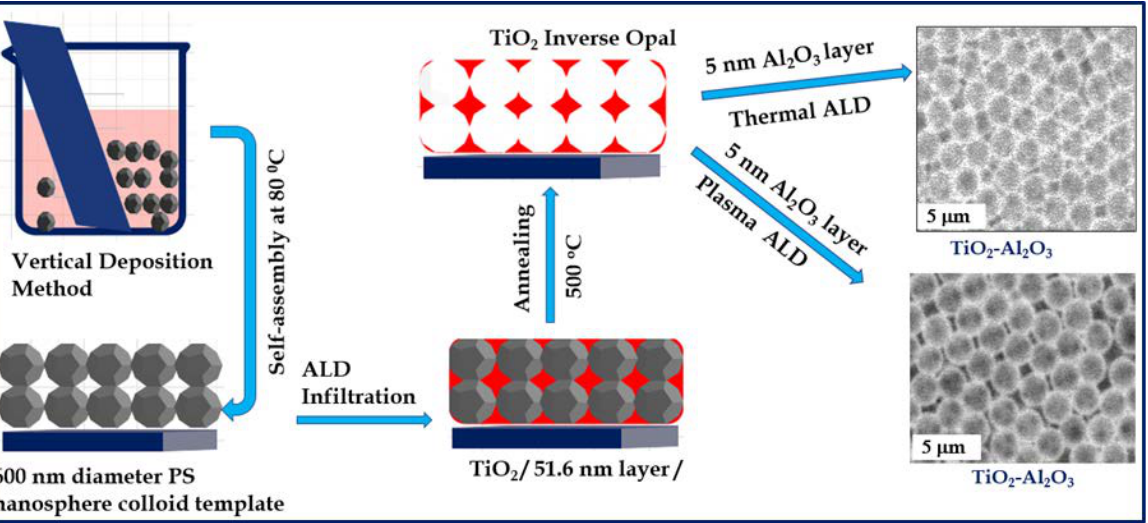
Figure 1. Experimental route for synthesis of the TiO 2 IO and Al 2 O 3 /TiO 2 composites by ALD and vertical layer